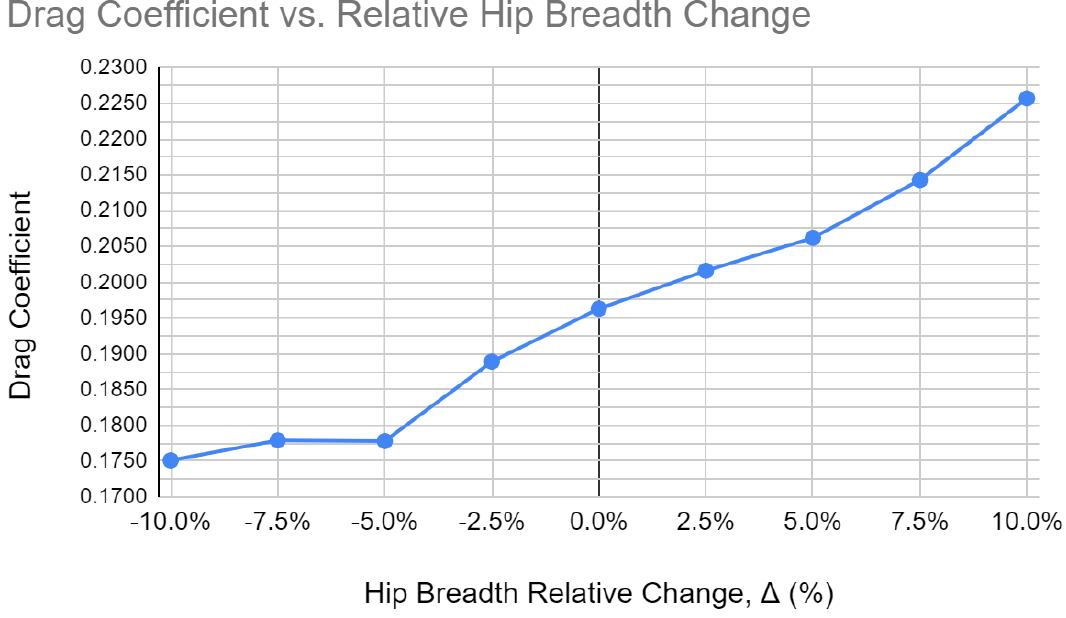
Figure 13. Graph of Relative Hip Breadth Change (top view model) vs. Drag Coefficient.